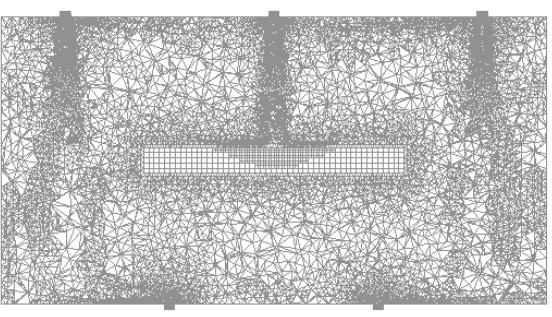
Figure 5. XZ cross section of the adapted mesh.